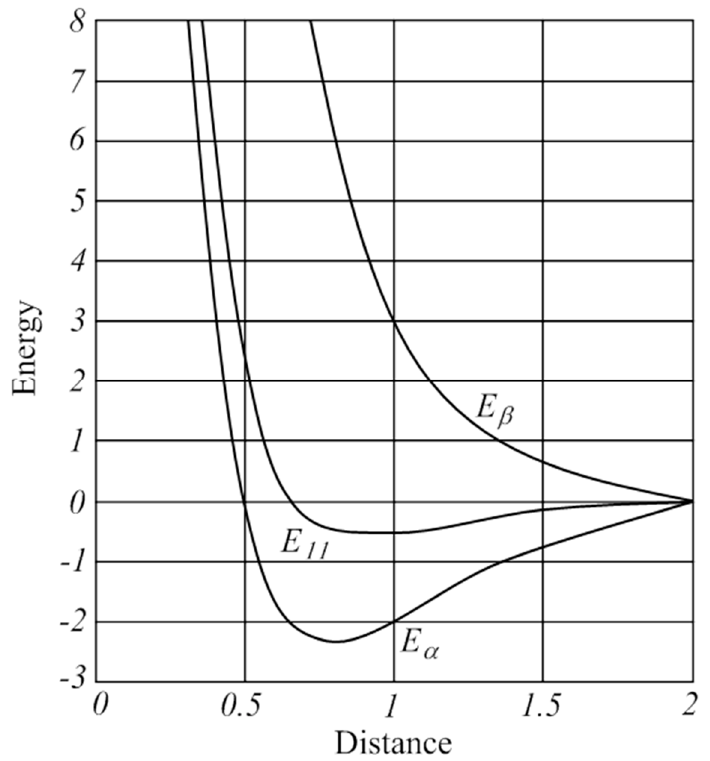
Figure 1. Potential energy curves of dihydrogen calculated classically (E 11 ) and using the wave function Ψ (E α and E β ) by Heitler and London. Redrawn from ref [10].